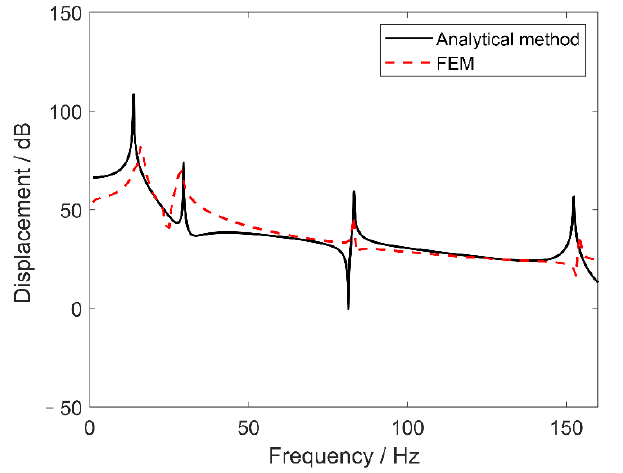
Figure 3. Comparison of vibration response between analytical method and the FEM. The location of the response point is x = 0 m.